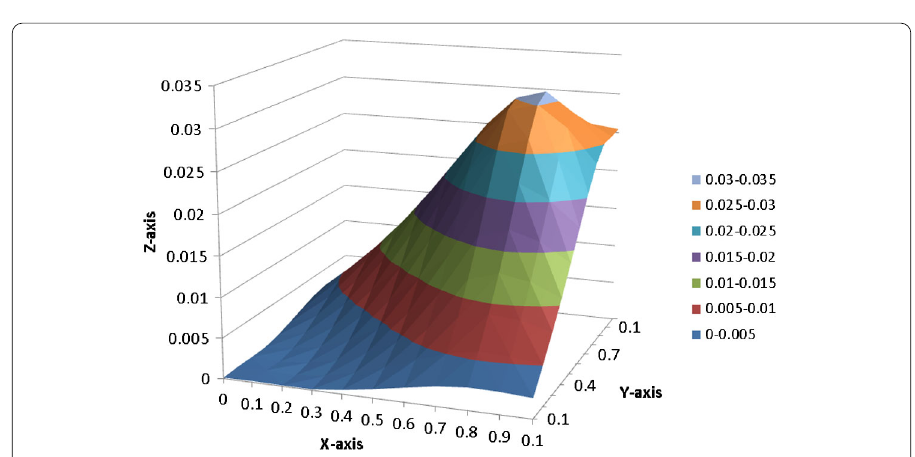
Figure 13 Numerical solution by the FSkG(C-N) method when α = 0.60 of Example 2